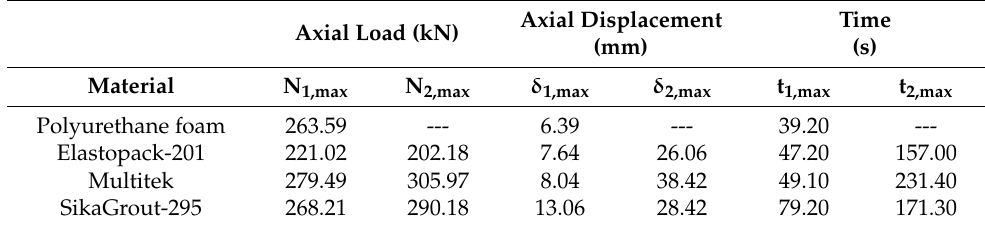
Table 2. Results obtained during the tests in each cycle.